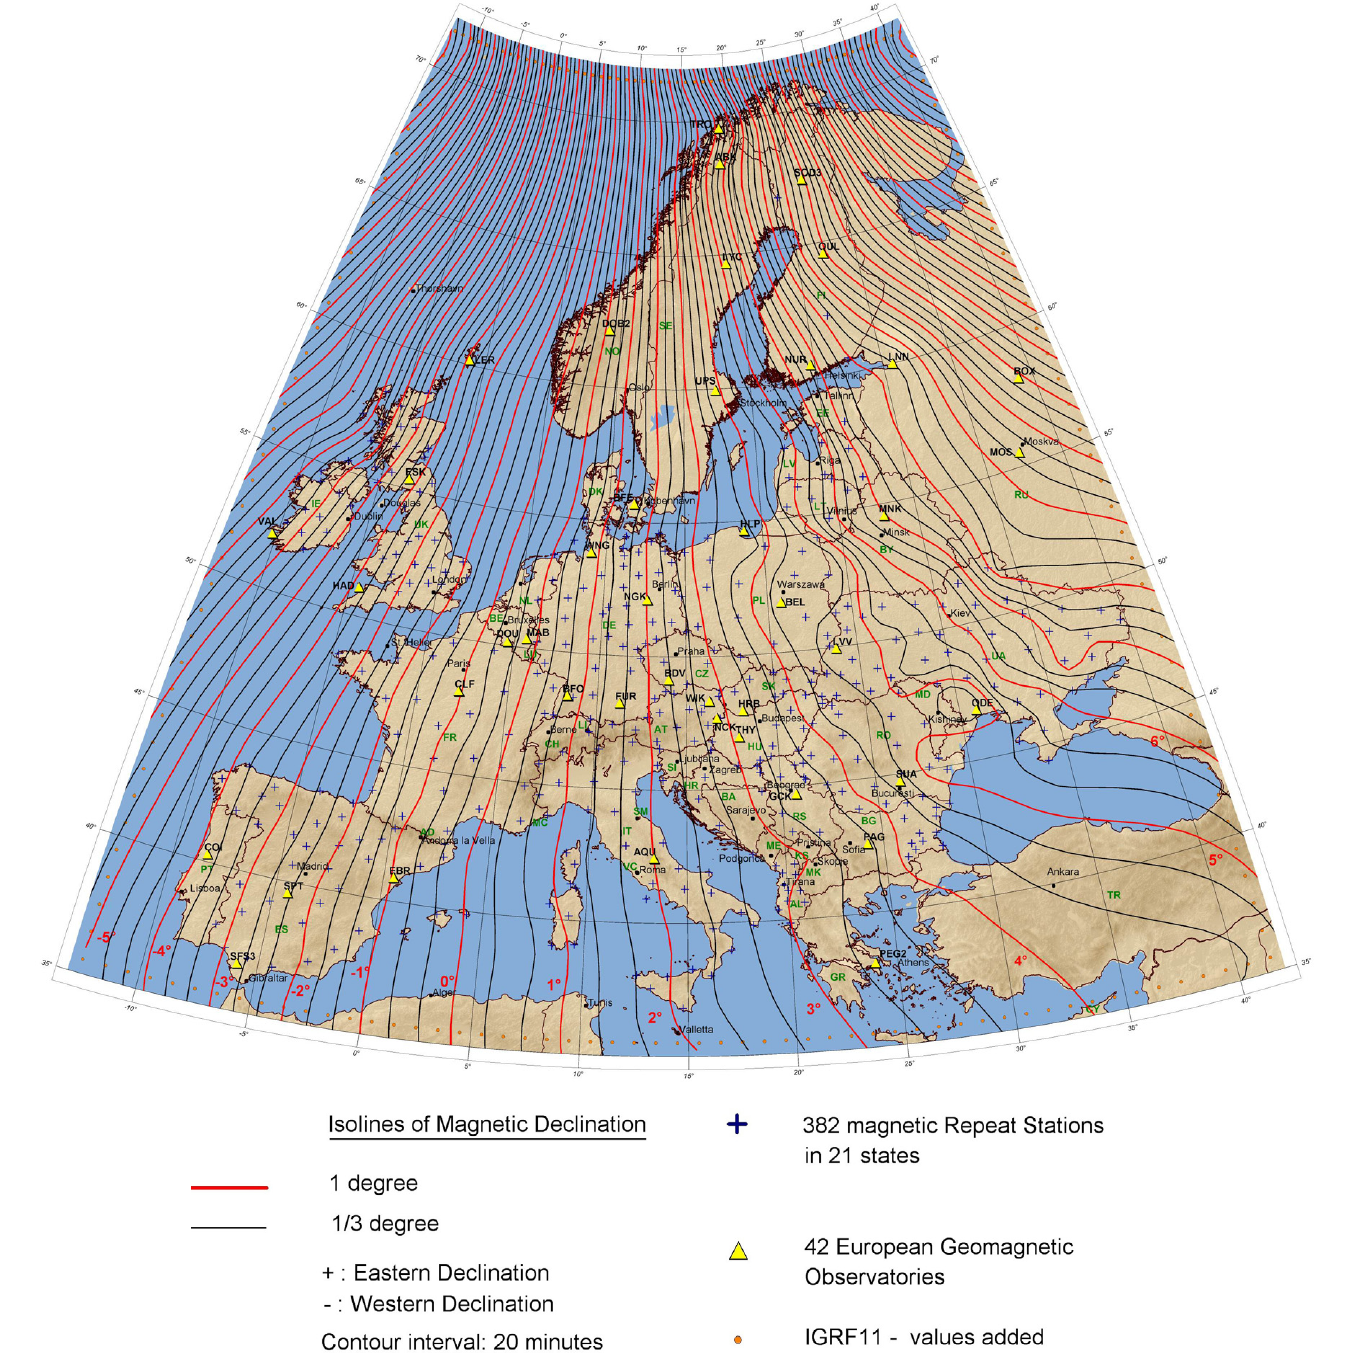
Figure 5. (Top) Magnetic Declination 2006, product of MagNetE - Magnetic Network in Europe: the final layout of the European declination 2006 map. (Bottom) Legend of the declination 2006